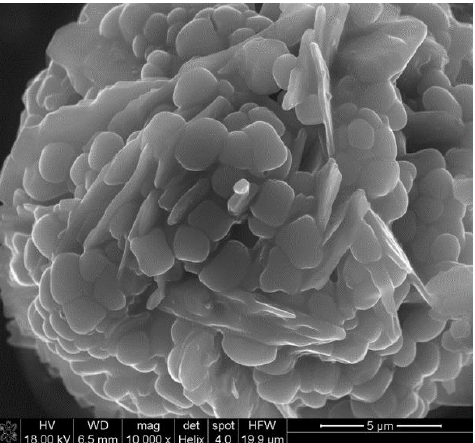
Figure 17. Aerosol grain agglomerates (approximately 30 m) obtained in a dry environment (humidity 30%). Samples were taken from the bottom of the test chamber.